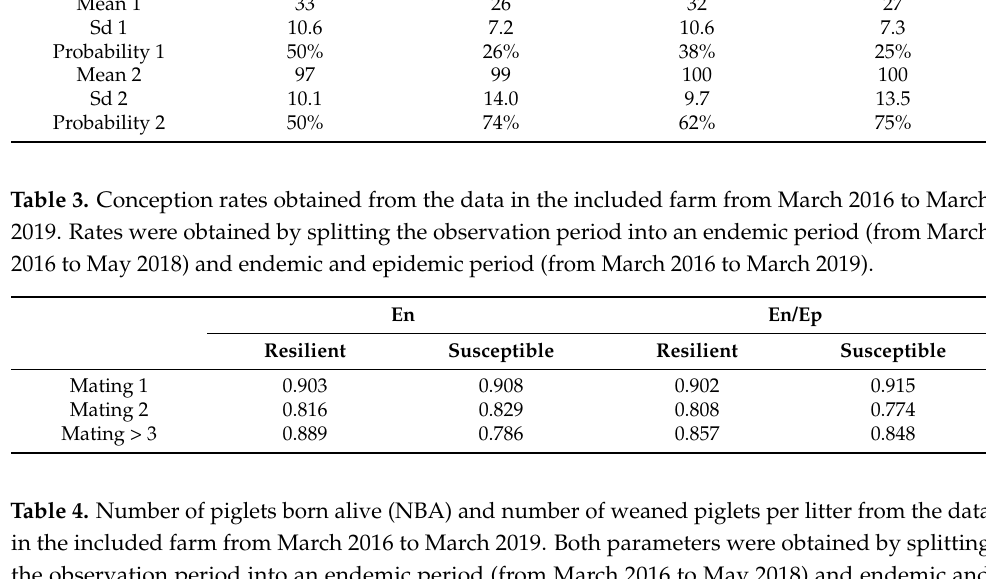
Table 2. Time interval distributions from the beginning of gestation to time of pregnancy losses from registered data from March 2016 to March 2019. Different distributions were obtained when splitting the observation period into an endemic period (En) (from March 2016 to May 2018) and endemic and epidemic period (En/Ep) (from March 2016 to March 2019). The resulting time interval distributions fit a mixture of two normal distributions. N (x,y) means a normal distribution, where x and y are the mean and standard deviation of the distribution, respectively. Thus, for example, for resilient sows in the endemic status, the two normal were X 1 ≈ N (33,10.6) and X 2 ≈ N (97,10.1), with a probability of p 1 = 50% and p 2 = 50%, respectively. En En/Ep Resilient Susceptible Resilient Susceptible